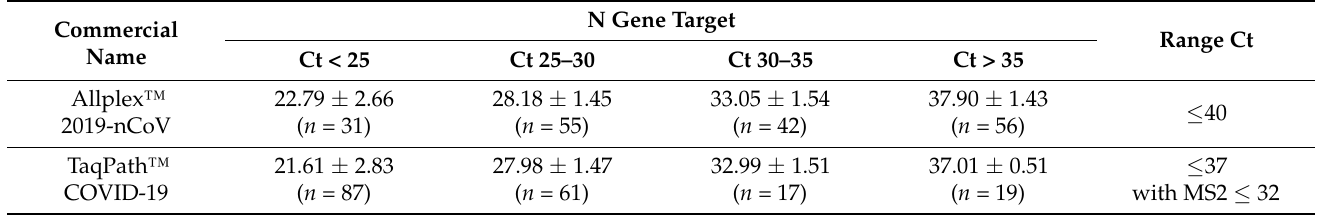
Table 2. N gene Ct value tested with Allplex™ 2019-nCoV Assay and TaqPath™